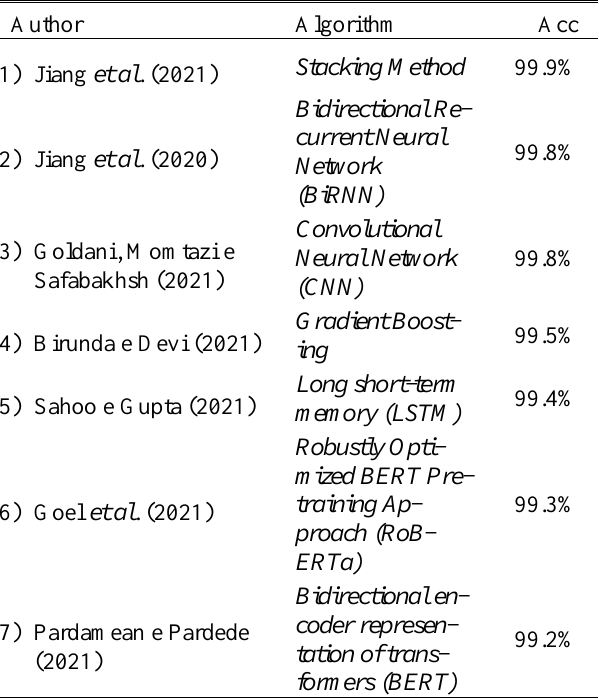
Table 3. Accuracy of the analyzed algorithms used to identify fake news. Source: The